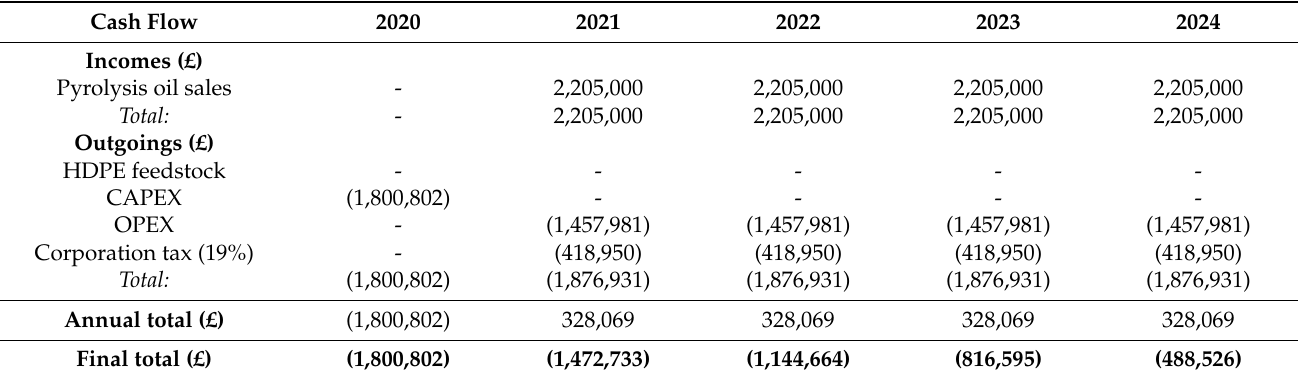
Table 6. Cash flow statement for conversion process of HDPE to pyrolysis oils at a feed rate of 100 kg/h and a sale price of